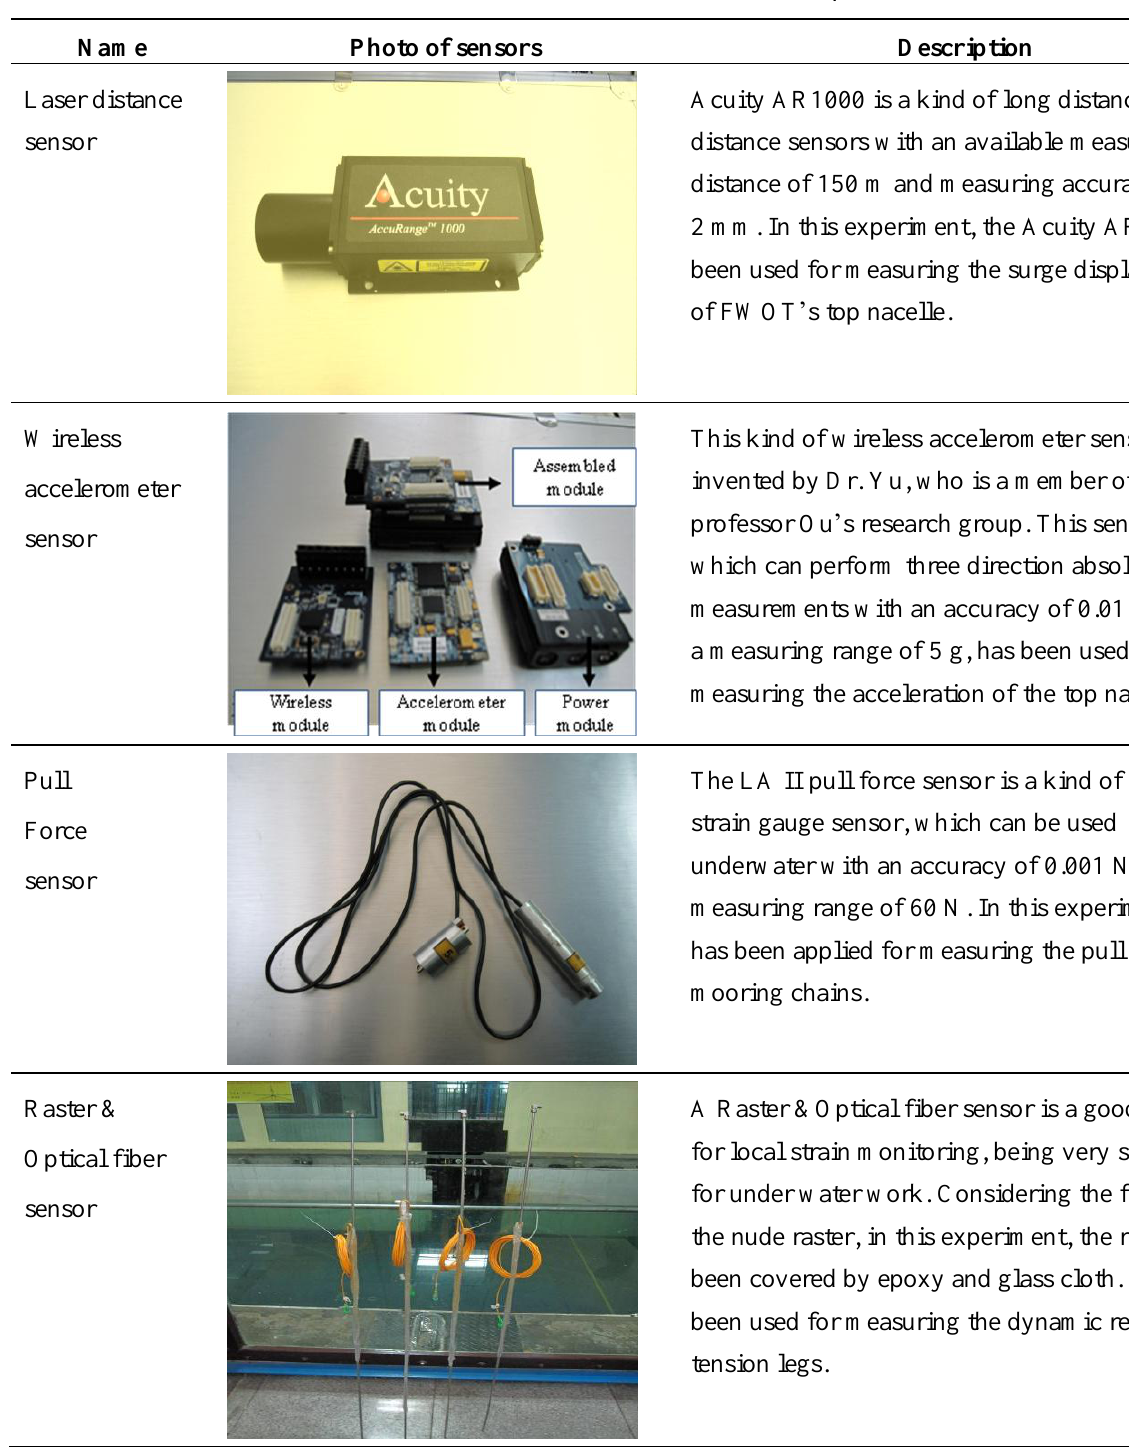
Table 2. The main sensors used for this